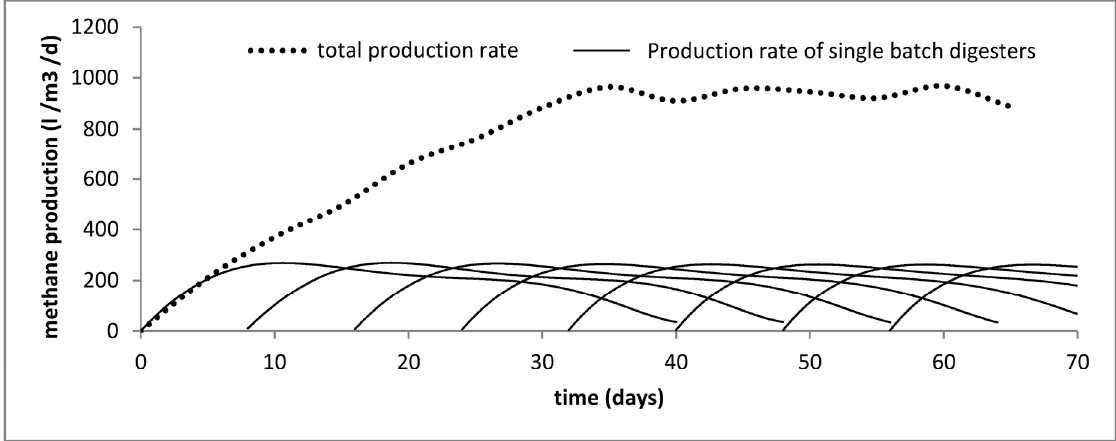
Figure 3. Methane production pattern of five off-set run batch digesters and their cumulative production